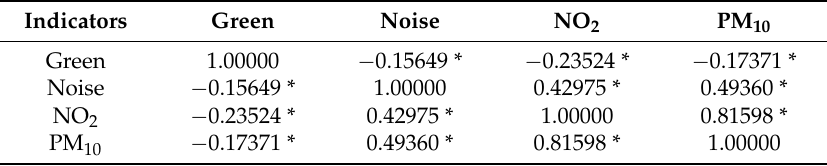
Table 5. Spearman rank correlation coefficients between environmental